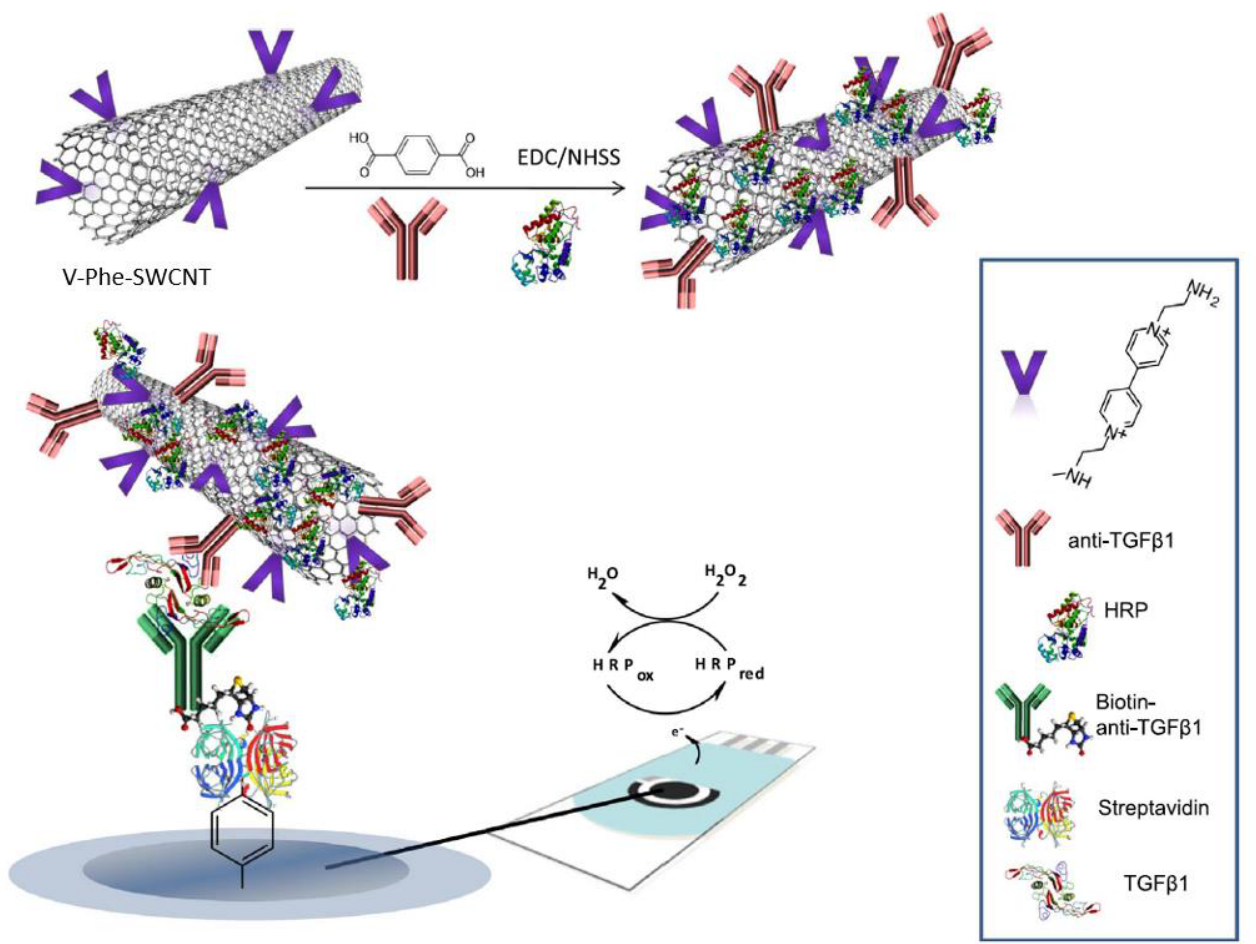
Figure 6. Schematic illustration of the different steps involved in the construction of an amperometric immunosensor for TGF- β 1 using V-Phe-SWCNT hybrids. Ab 1 , HRP and a viologen were immobilized on SWCNT. Ab 2 was immobilized via Bt-SAv on a screen printed carbon electrode (SPCE) grafted with carboxyl aryl diazonium. The signal generated by HRP catalyzed H 2 O 2 reduction was amplified by the redox mediator viologen. Reprinted from [116] with permission from Elsevier.